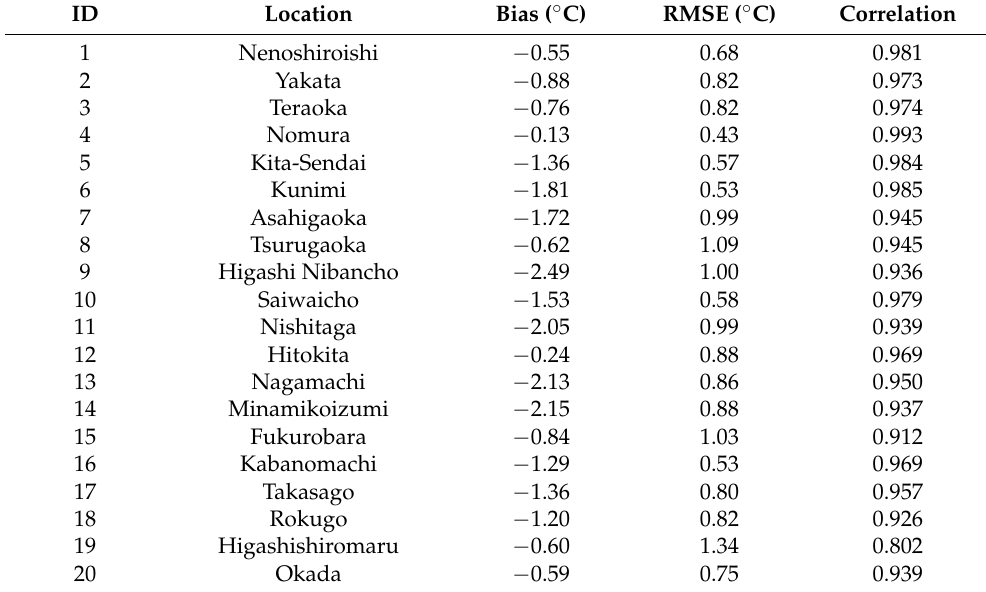
Table 3. Results of precision inspections for temperature numerical computation.